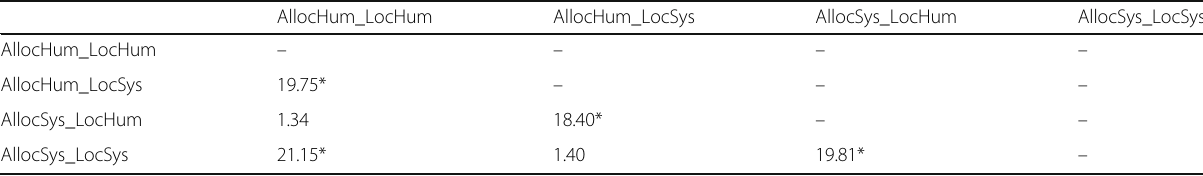
Table 4 Differences in interactions with the navigation system between groups AllocHum_LocHum AllocHum_LocSys AllocSys_LocHum AllocSys_LocSys AllocHum_LocHum